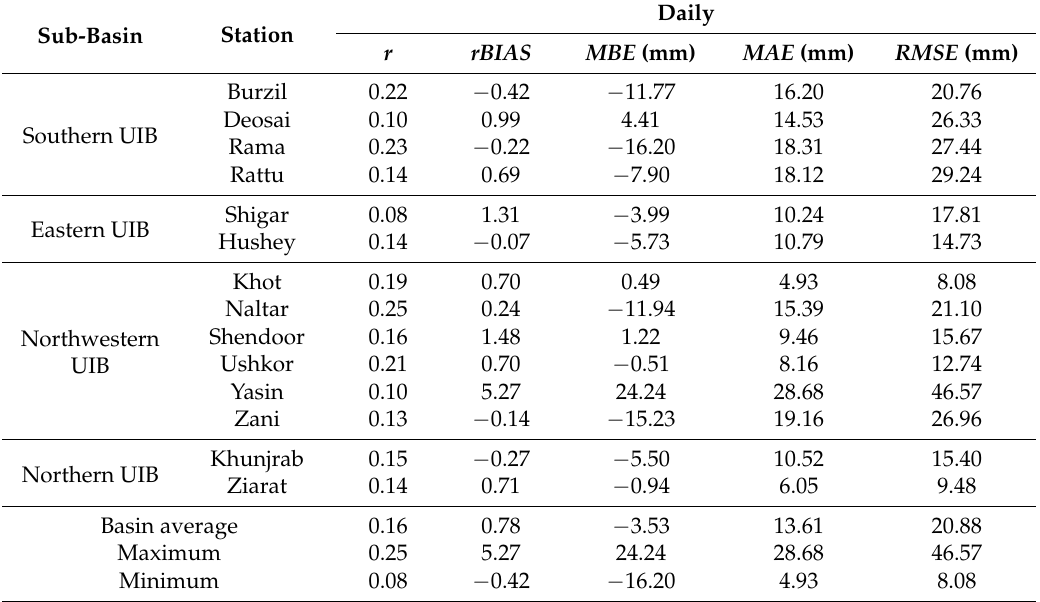
Table 3. Statistical analysis for daily aggregates. UIB: Upper Indus Basin; r : correlation coefficient; rBIAS : mean relative bias error; MBE : mean bias error; MAE : mean absolute error; RMSE : root mean square